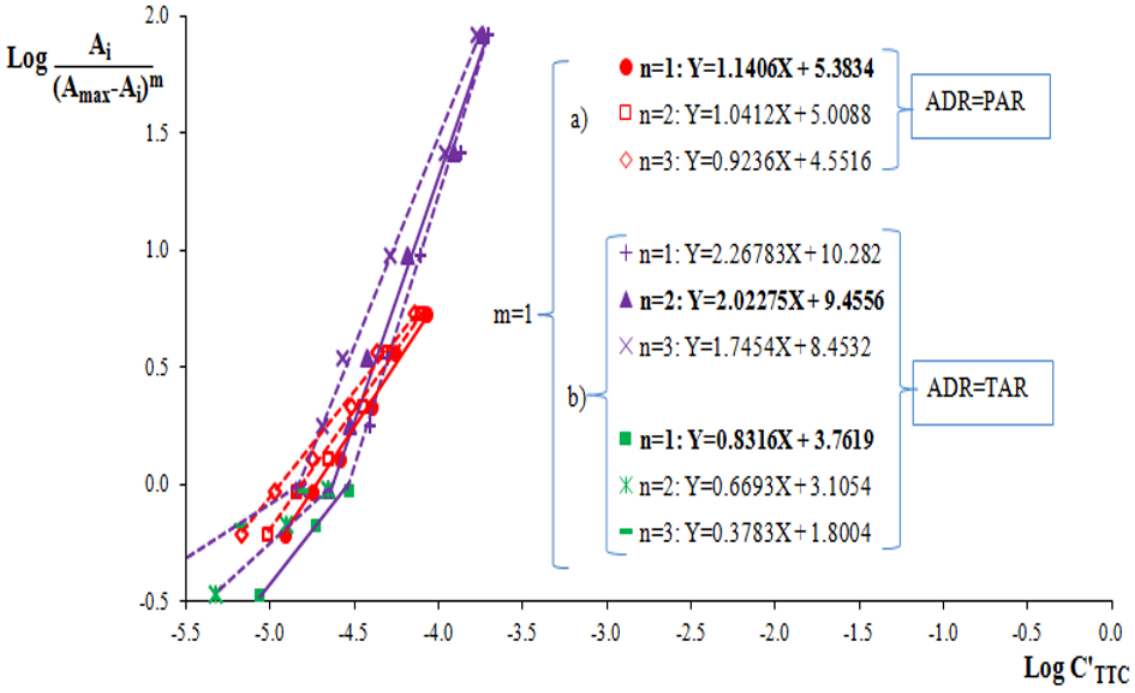
Figure 5. Determination of the constants of association ( β ) and the TTC-to-Ga(III) molar ratios by the mobile equilibrium method. a) Ga(III)-PAR-TTC (red markers): pH=6.5, C b) Ga(III)-TAR-TTC (violet and green markers): pH=6.7, C